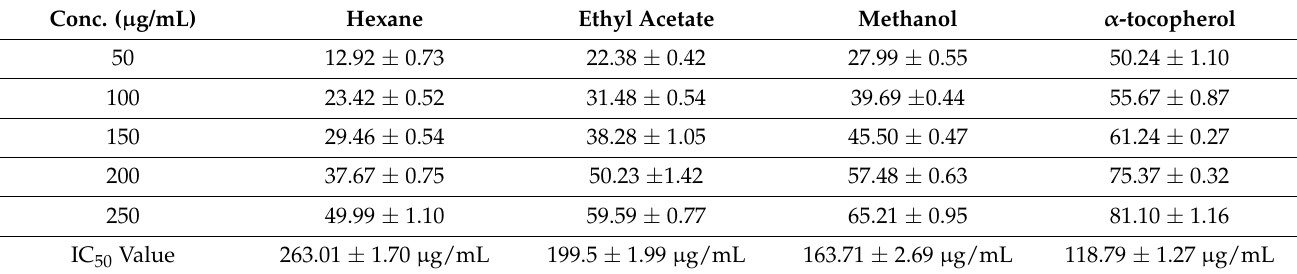
Table 3. DPPH free radical scavenging activity of different extracts of A. chasmanthum rhizome.